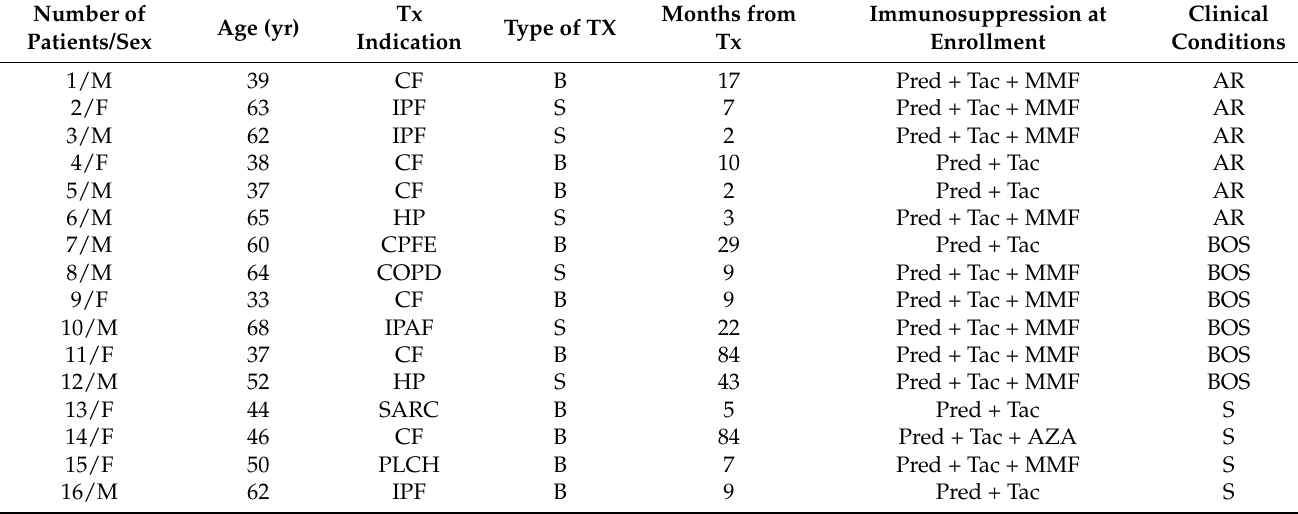
Table 1. Demographic data of 16 enrolled patients. Abbreviations: M = male, F = female, CF: cystic fibrosis, IPF: idio- pathic pulmonary fibrosis, HP: hypersensitivity pneumonitis, CPFE = combined pulmonary fibrosis and emphysema, COPD: chronic obstructive pulmonary disease, IPAF = Interstitial pneumoniae with autoimmune features, Sarc = sar- coidosis, PLCH = pulmonary langherans cells histiocytosis. B = Bilateral, S = single, Pred = Prednisone, Tac = tacrolimus, MMF = mycophenolate mofetil, AZA =